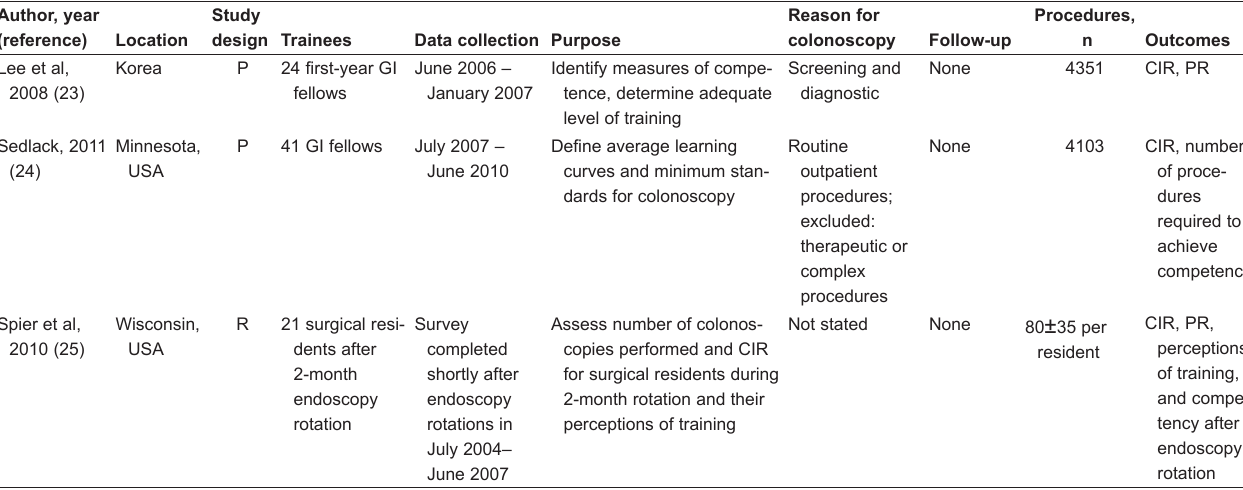
TAble 1 Characteristics of studies related to training and competency Author, year